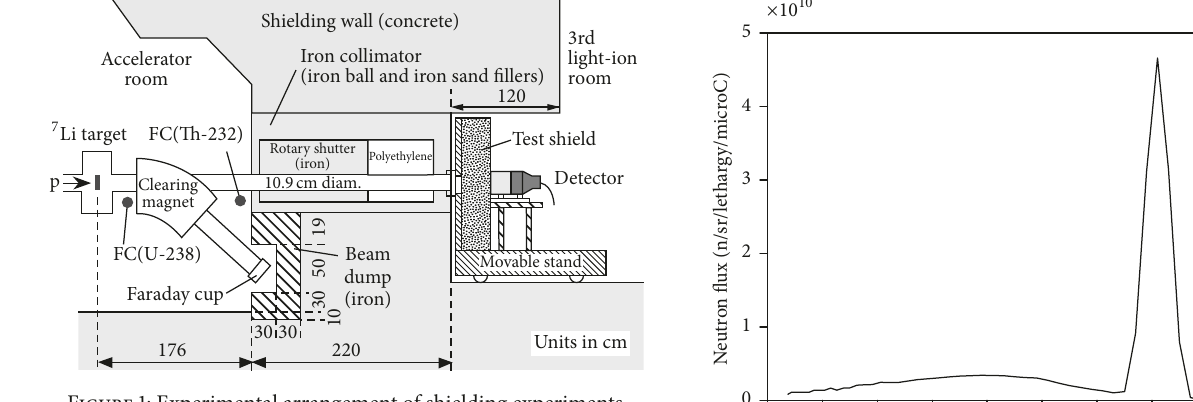
Figure 1: Experimental arrangement of shielding experiments.